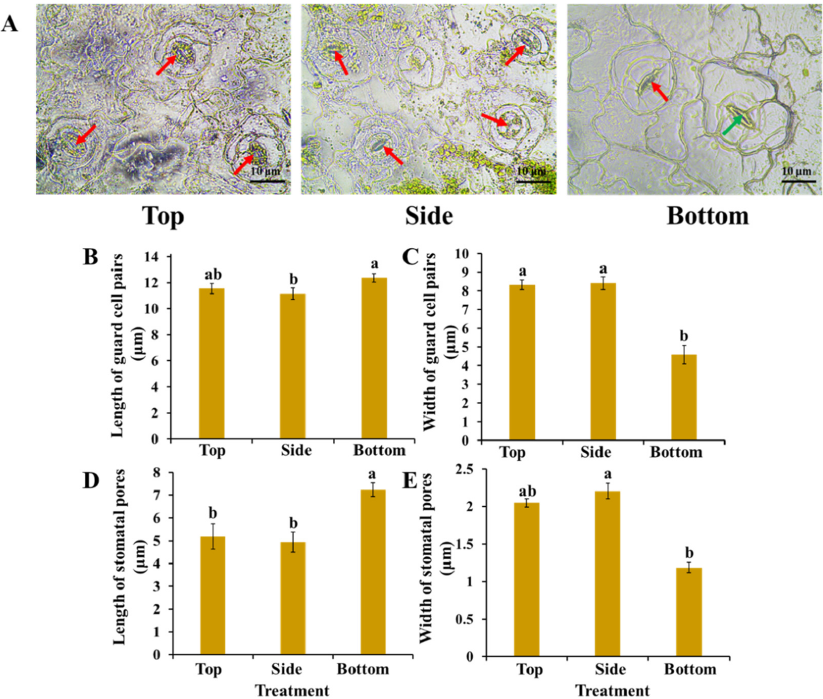
Figure 5. Stomatal micrographs ( A ) (40 × ) and changes in the stomatal properties of strawberry ‘Sulhyang’ plants as affected by the lighting direction after 45 days of cultivation. Length ( B ) and width ( C ) of guard cell pairs, length ( D ) and width ( E ) of stomatal pores. Vertical bars indicate the means ± standard error ( n = 6). Different lowercase letters indicate significant separations within treatments by Duncan’s multiple range test at p ≤ 0.05. Bars indicate 10 µ m. Red arrows indicate opened stomatal pores, while green arrows indicate closed stomatal